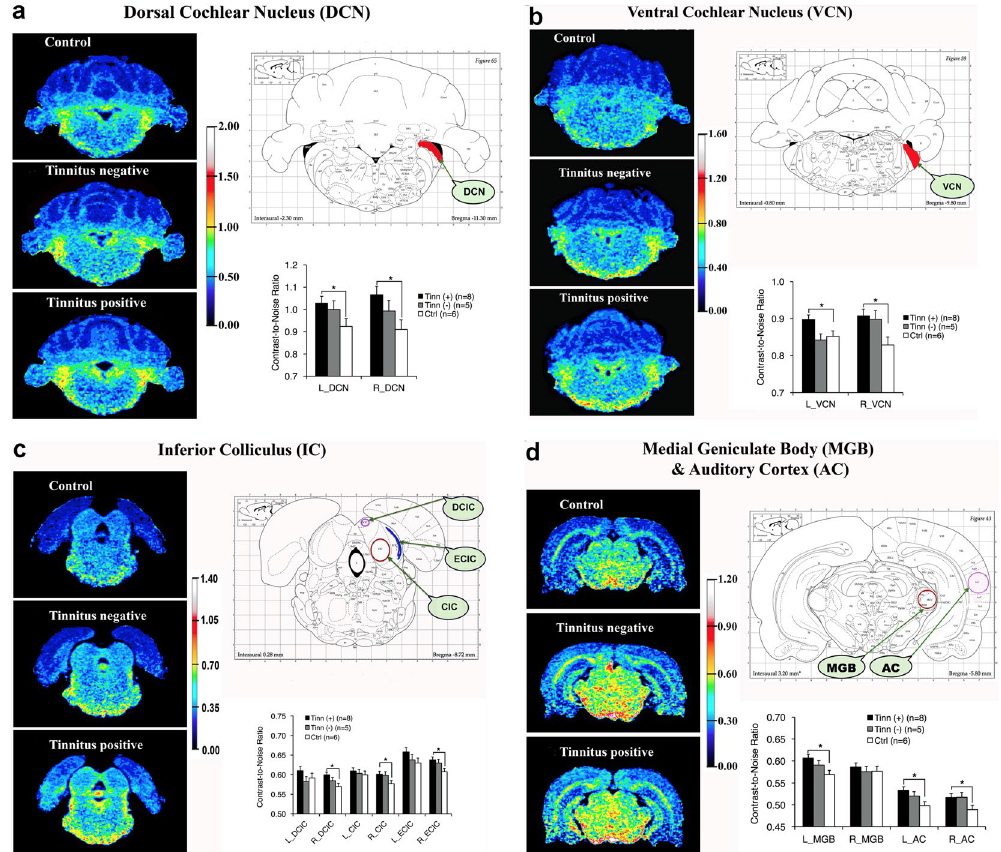
Figure 3. Blast-induced tinnitus ( + ) rats had higher neural activity in several central auditory structures compared to control (ctrl) rats, though there were no significant differences between tinnitus ( + ) and tinnitus ( − ) rats. Images were color-coded according to manganese uptake intensity, as defined by the color scale- bar. Color-coded images are shown for a representative tinnitus( + ), tinnitus( − ) and control (ctrl) rat. A rat brain atlas was used to guide ROI placement. The bar graphs indicate the averaged uptake values per group and brain region. ( a ) Significantly higher manganese uptake was found in the left and right DCNs of the tinnitus( + ) group, compared to the control group, as well as in ( b ) the left and right VCNs; ( c ) the right DCIC, CIC and ECIC, and; ( d ) the left MGB and the left and right ACs. For all graphs, error bars represent standard error of the mean. * Indicates statistical significance (p < 0.05). Atlases were adapted from The Rat Brain In Sterotaxic Coordinates, 4 th Edition by Paxinos and Watson (1998) with permission from the publisher.